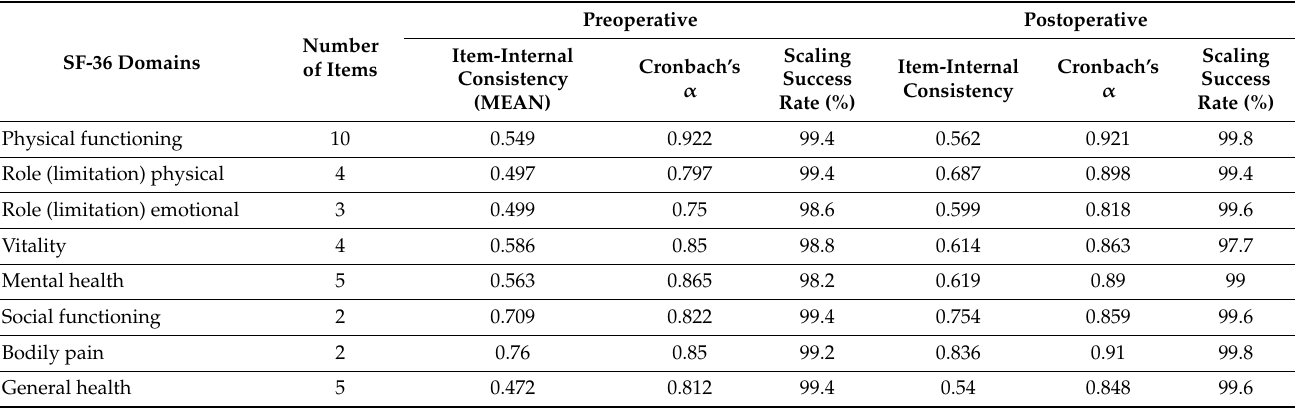
Table 4. Reliability